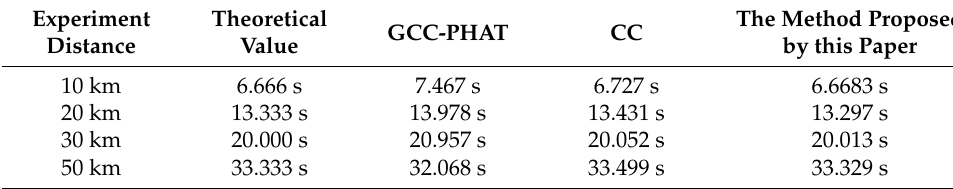
Table 3. The comparison experiment between the method and other